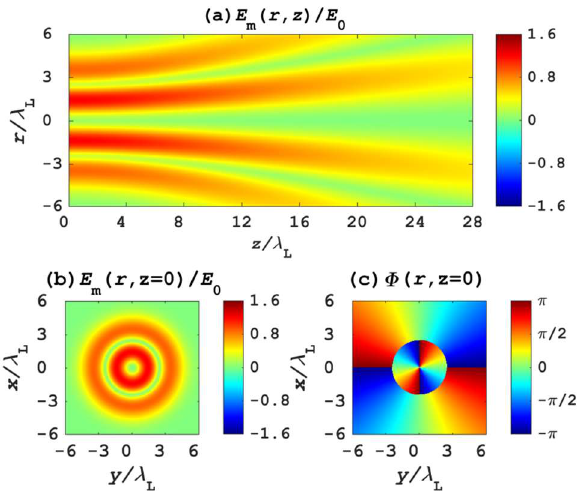
Figure 2. The field magnitude and phase distributions of the double-ring-shaped Laguerre-Gaussian vortex laser beam of LG 2 mode in free space: ( a ) The longitudinal view of the normalized field magnitude distribution E m ( r , z ) / E 0 ; ( b ) the cross-sectional view of the normalized field magnitude distribution E m ( r , z = 0 ) / E 0 on the plane of beam waist; ( c ) the cross-sectional view of principal argument distribution Φ ( r , z = 0 ) of the complex field of laser beam on the plane of beam waist.